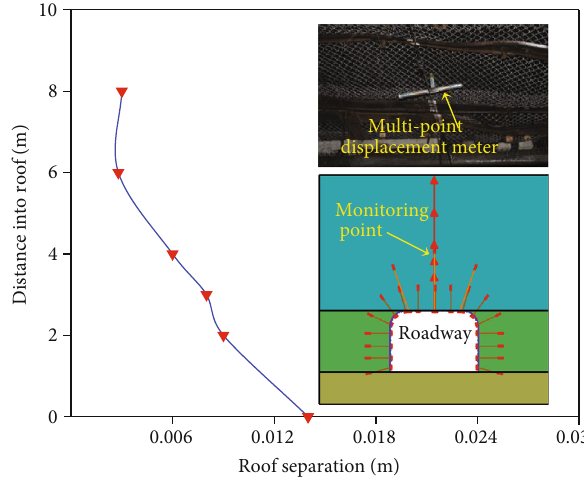
Figure 14: Separation monitoring of roadway